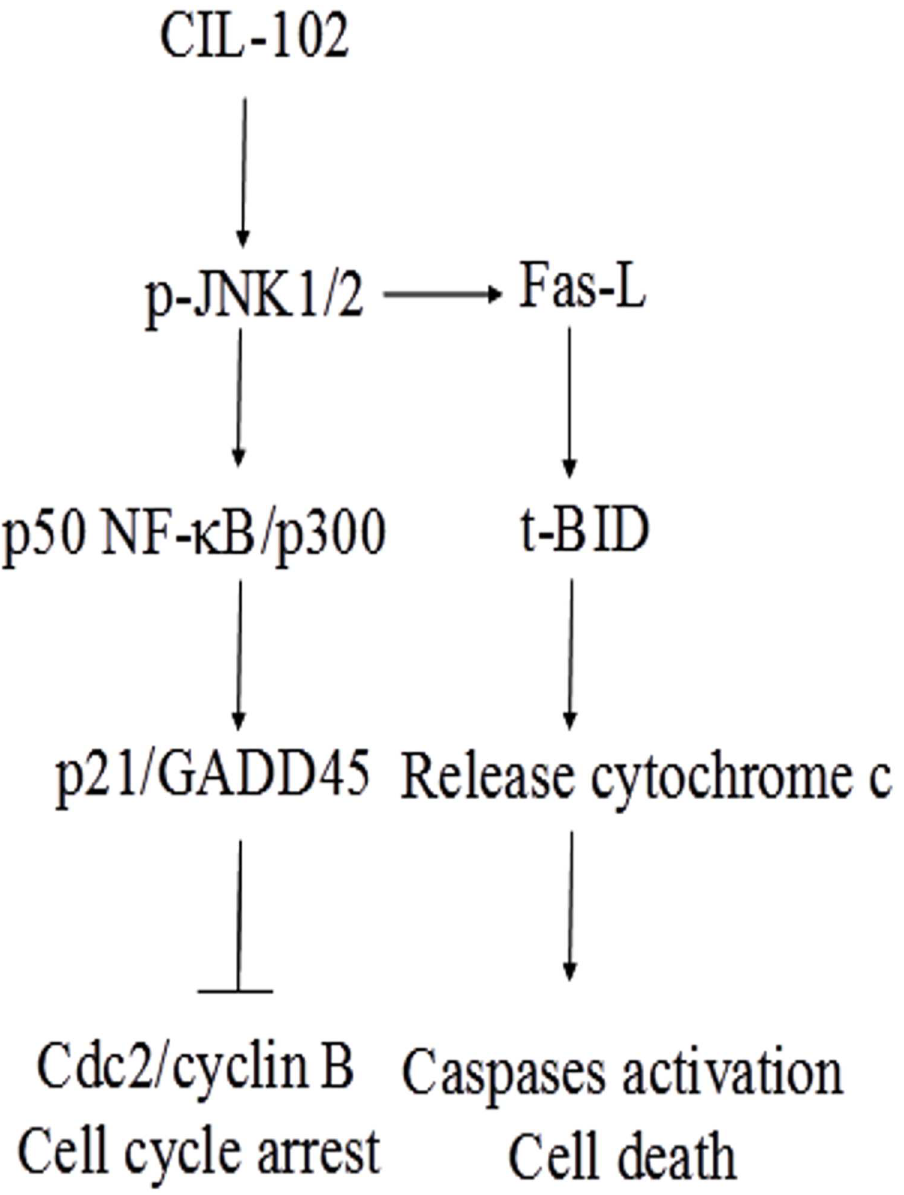
Fig 7. Schematic presentation of the signaling pathways involved in CIL-102 induced cell cycle arrest G2/M phase and apoptosis in human DLD-1 cancer cells. The effect of CIL-102on the activationJNK1/2, and p50 NF- κ B/p300 pathways, which leads to p21 and GADD45 expressionand cdc2/cyclinB inactivation and increasescell cycle arrest in human DLD-1. CIL-102 triggeredthe extrinsic apoptosispathwaythrough activationof Fas-L and inductionof Bid cleavage,cytochrome c release and caspase-8,-3, -9